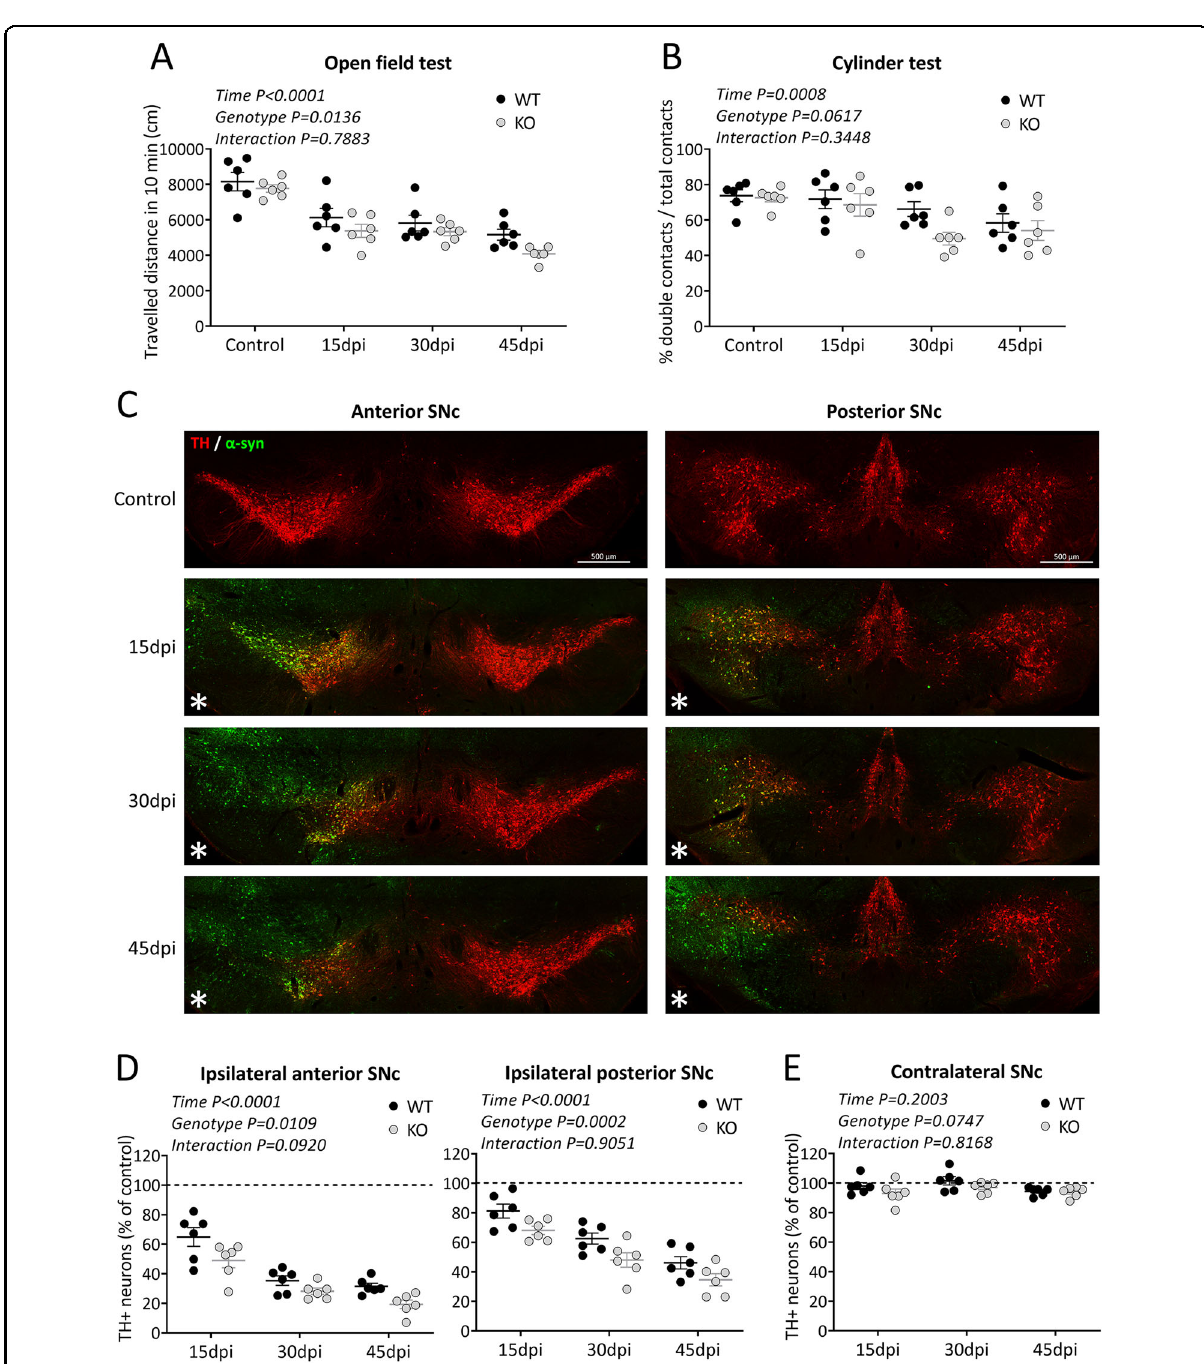
Fig. 2 TP53INP1 de fi ciency aggravates motor de fi cits and loss of nigral TH-positive neurons induced by AAV-mediated α -synuclein overexpression. A , B Assessment of motor performance using the open fi eld test for the spontaneous locomotor activity ( A ) and the cylinder test for the parkinsonian-like akinesia ( B ) in WT and Trp53inp1 − / − (KO) control mice and mice with unilateral intranigral injection of AAV2-CBA-human- α - synuclein at 15, 30, and 45 dpi. The injection leads to progressive de fi cits for the two genotypes, which were signi fi cantly worsened in Trp53inp1 − / − mice for locomotor performance in the open fi eld. C Illustrative images of dually immunostained sections showing the time course of human α - synuclein expression and of TH neuron loss in the substantia nigra of WT mice. Note that human α -synuclein detection is limited to the injected side and associated with a progressive reduction in the numbers of labeled TH neurons, while no apparent loss is observed in the contralateral side. D Total numbers of TH + neurons in the anterior and posterior subdivisions of the ipsilateral SNc measured in WT and KO mice at 15, 30, and 45 dpi and expressed as % of control. The progressive loss of these neurons both in the anterior and the posterior subdivisions of the injected SN was aggravated in KO mice. E Lack of changes in the numbers of TH + neurons in the overall contralateral SNc at the time points examined in WT and KO mice expressed as a percent of control. In all graphs, data are means ± SEM of 6 mice per group, and the results of the two-way ANOVA are indicated within each graph. Only signi fi cant interaction is